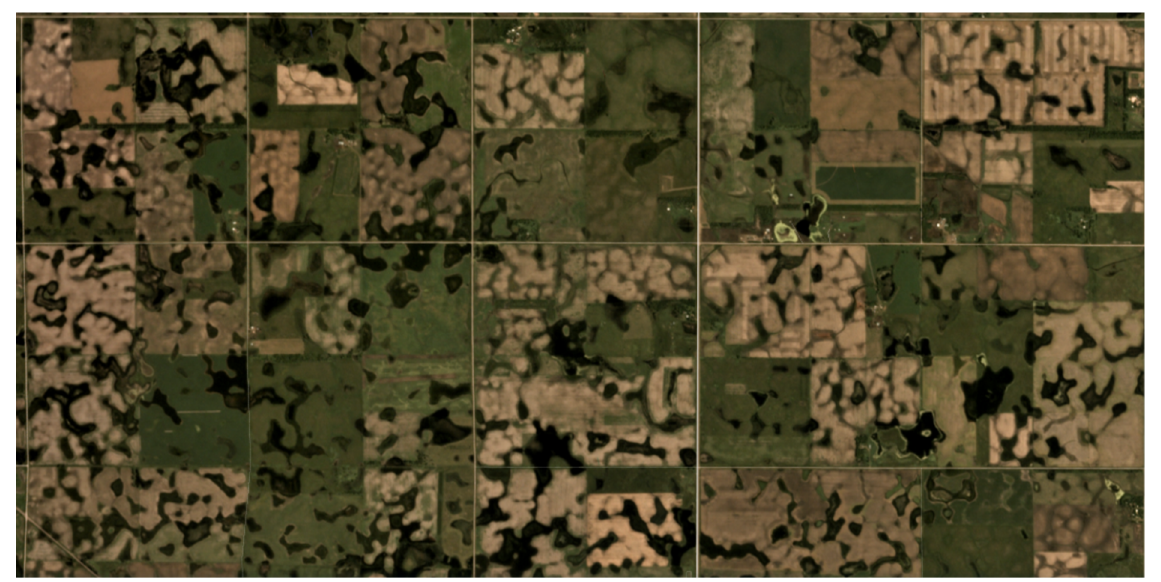
Figure 4. NDWI map of study area for April 2018 ( left ) and June 2019 ( right ) showing general in- crease in NDWI values across most of the study area.